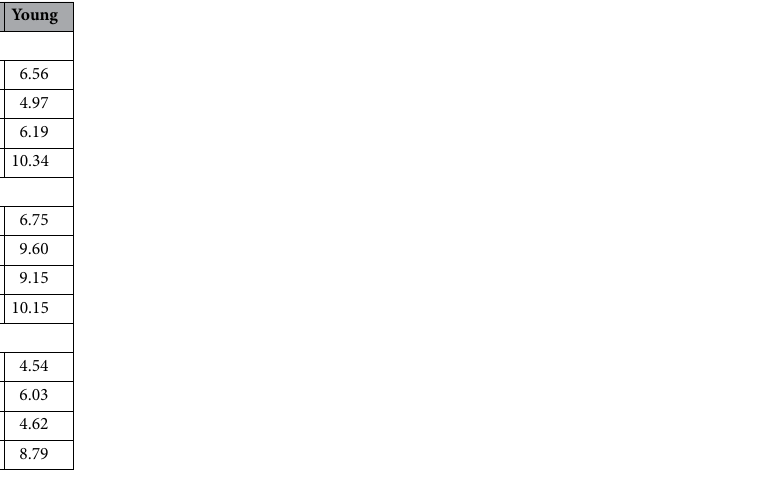
Table 4. Coefficients of variation (c.v.) of the studied faecal nutrients (nitrogen—fN; neutral detergent fibre— fNDF; acid detergent fibre—fADF) for each dataset (hinds, stags and young) and each sampling period.